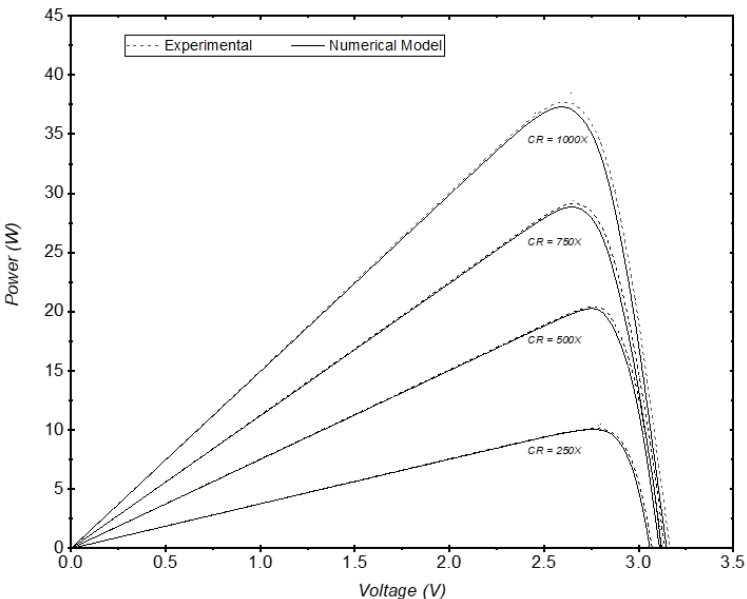
Figure 10. Verification of the mathematical model results with the datasheet of P-V characteristics in different concentration ratios for FULLSUNS Triple-Junction Photovoltaic solar cell.